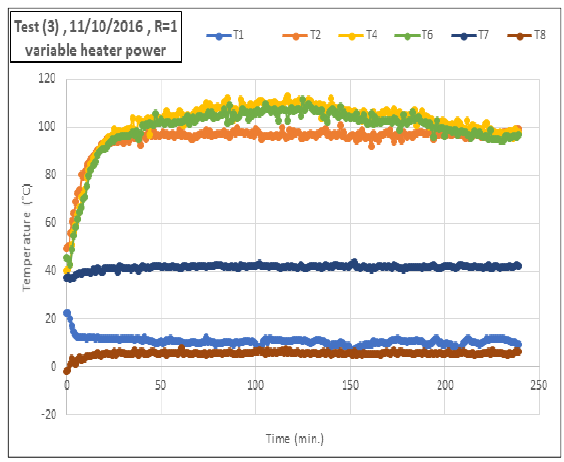
Fig. 10c. Air temperature with time for test 3.